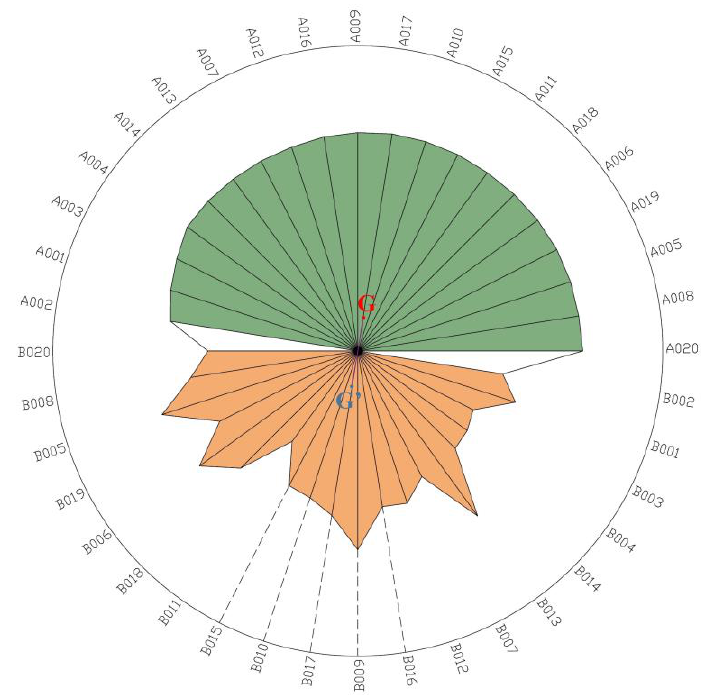
Figure 7. The cumulative BIC of 24 offices and neighborhoods based on the average scores of each indicator.